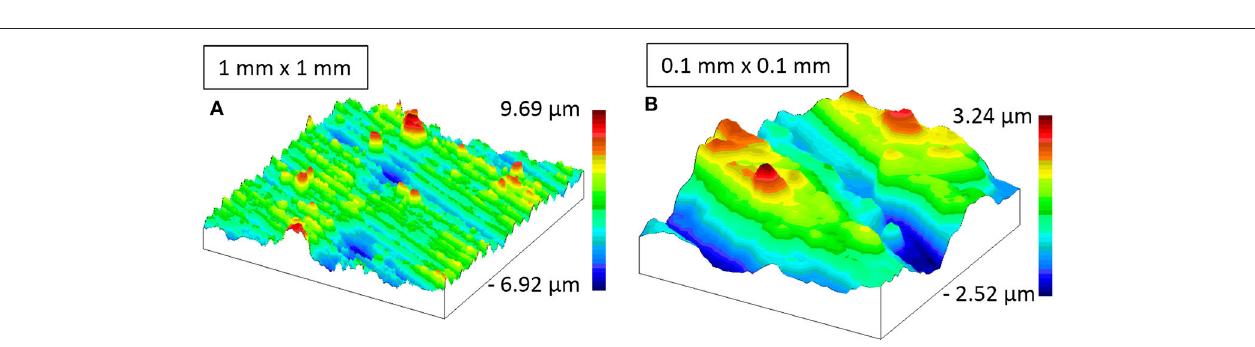
FIGURE 6 | Topography of a turned surface (Sdq = 0.231; Sdr = 2.264%). (A) 1mm by 1mm measuring area. (B) 0.1mm by 0.1mm measuring area.